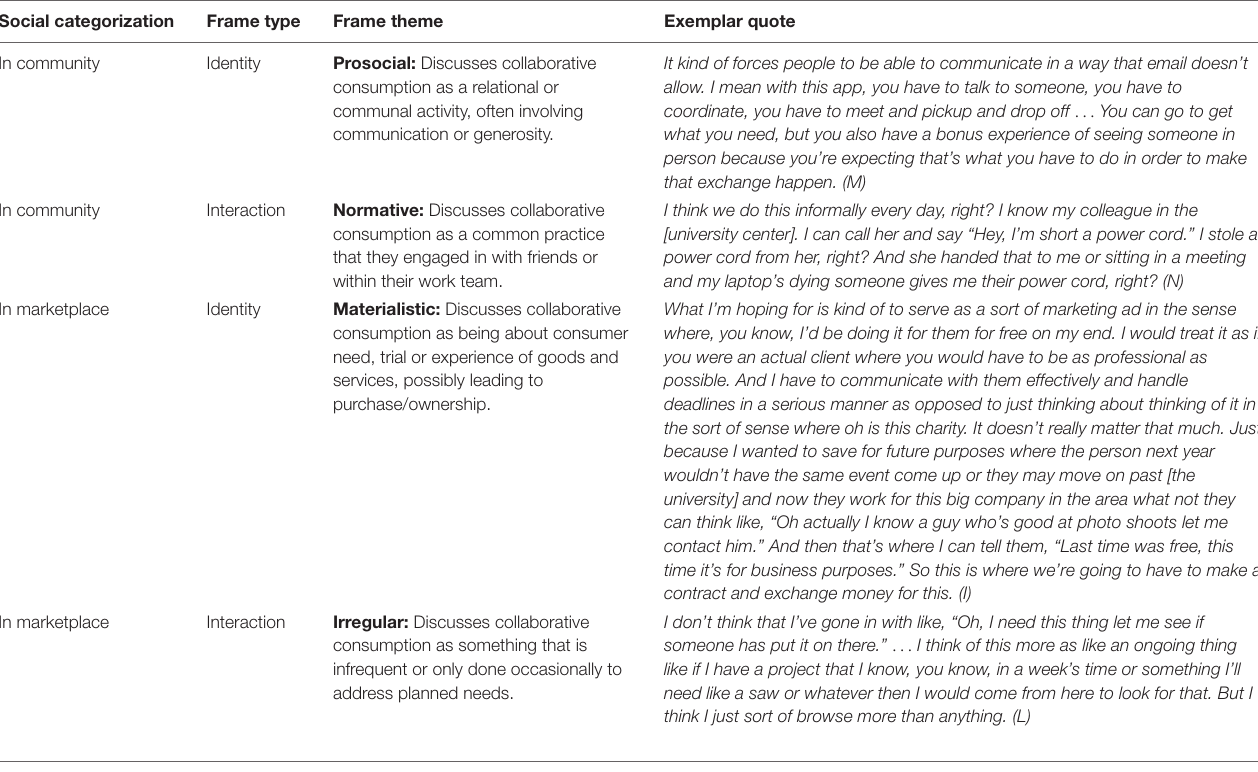
TABLE 3 | Identity and interaction framing based on social categorization.